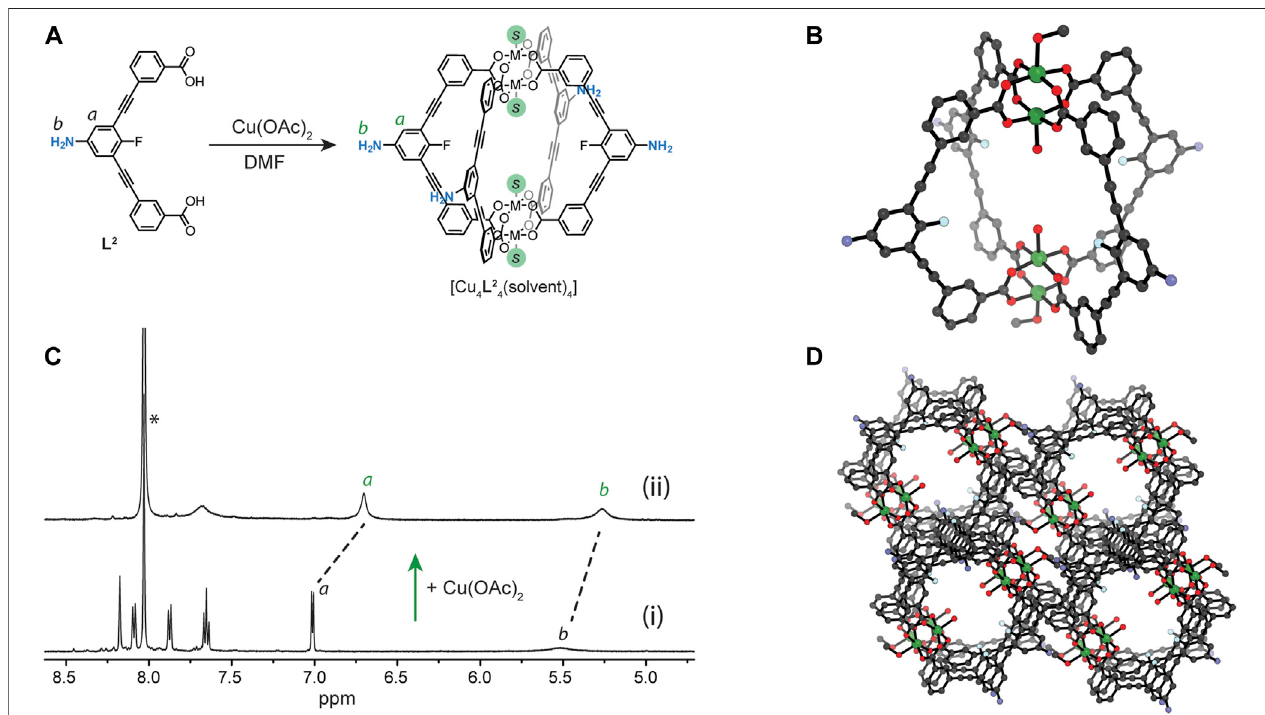
FIGURE 2 | (A) A scheme showing the Cu(II)-mediated self-assembly of Cu 4 L 2 4 ( 1 ); (B) 1 H NMR spectrum (500 MHz/DMF-d 7 ) showing MOC assembly in solution: (i) L 2 and (ii) L 2 after the addition of 1.1 equivalents of Cu(OAc) 2 ; (C) SCXRD of [ Cu 4 L 2 4 ( MeOH ) 2 ( H 2 O ) 2 ] ( 1 ); (D) crystal-packing of 1 along the b